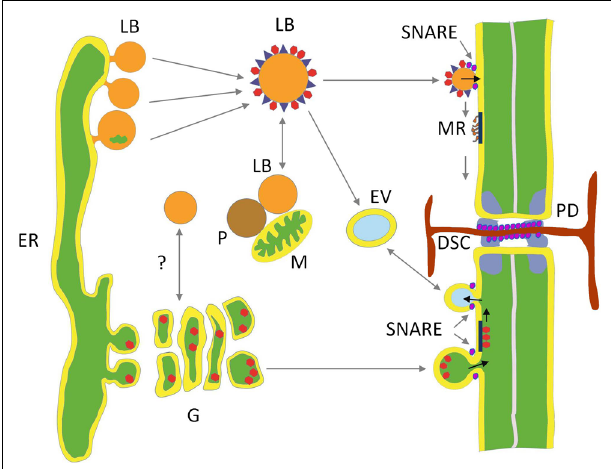
FIGURE 2 | Hypothetical model depicting two delivery paths to plasmodesmata. Lipid bodies (LBs) deliver cargo to membrane rafts (MR) at the inner leaflet of the plasma membrane (PM) and the plasmodesmal (PD) channel. LBs are pinched off from specialized areas of tubular ER.Their core of neutral lipids is covered by a protein coat composed of structural proteins, enriched by proteins donated by interacting organelles, like mitochondria (M), peroxisomes (P), early endosome vesicles (EV), and possibly Golgi (G) vesicles. Some of the LBs target PM and transfer proteins to MR that transport them to the PD cavity. In the dormant perennial shoot apical meristem one of the LB proteins is a peripherally associated 1,3- β -glucanase that hydrolyzes the callose plug of the dormancy sphincter complex (DSC).The secretory path delivers cargo that is packed in ER-derived vesicles, among which glycosylphosphatidylinositol (GPI)-anchored 1,3- β -glucanases, that are moved through the Golgi to fuse as exocytic vesicles with the PM, releasing their cargo to the outer side of the PM, where selected GPI-anchored proteins are potentially recruited by MRs for transport to the outer leaflet of the PD neck. Soluble NSF attachment protein receptors (SNAREs) mediate endocytosis, exocytosis, and presumably hemi-fusion of LBs with the